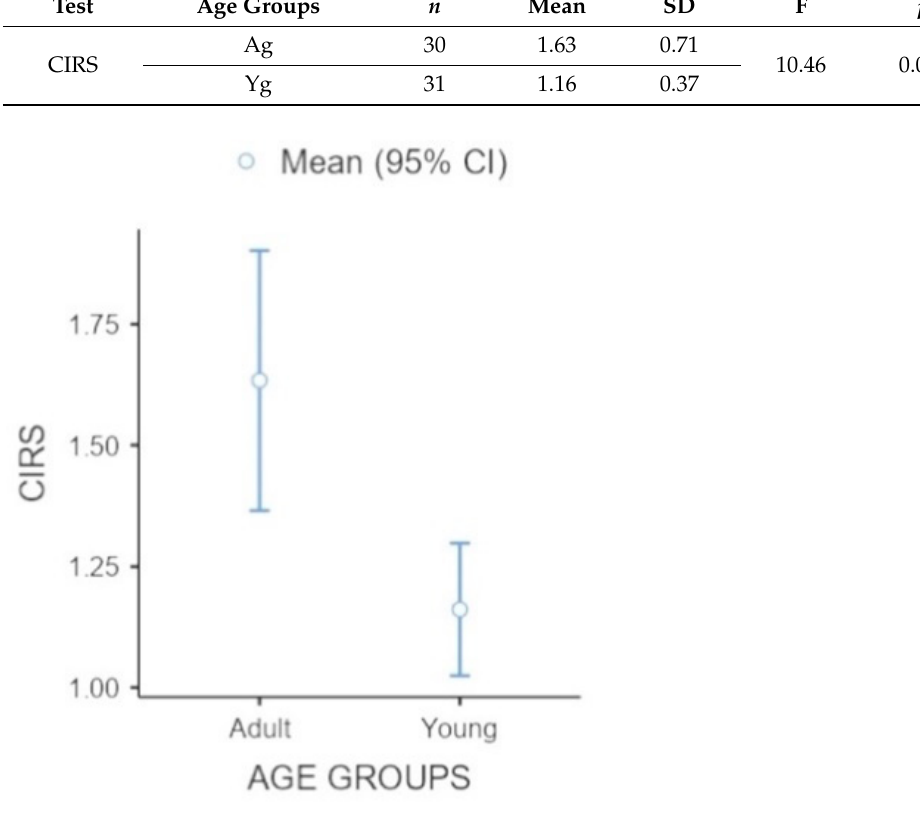
Figure 1. Representation of CIRS index by young and adult groups.